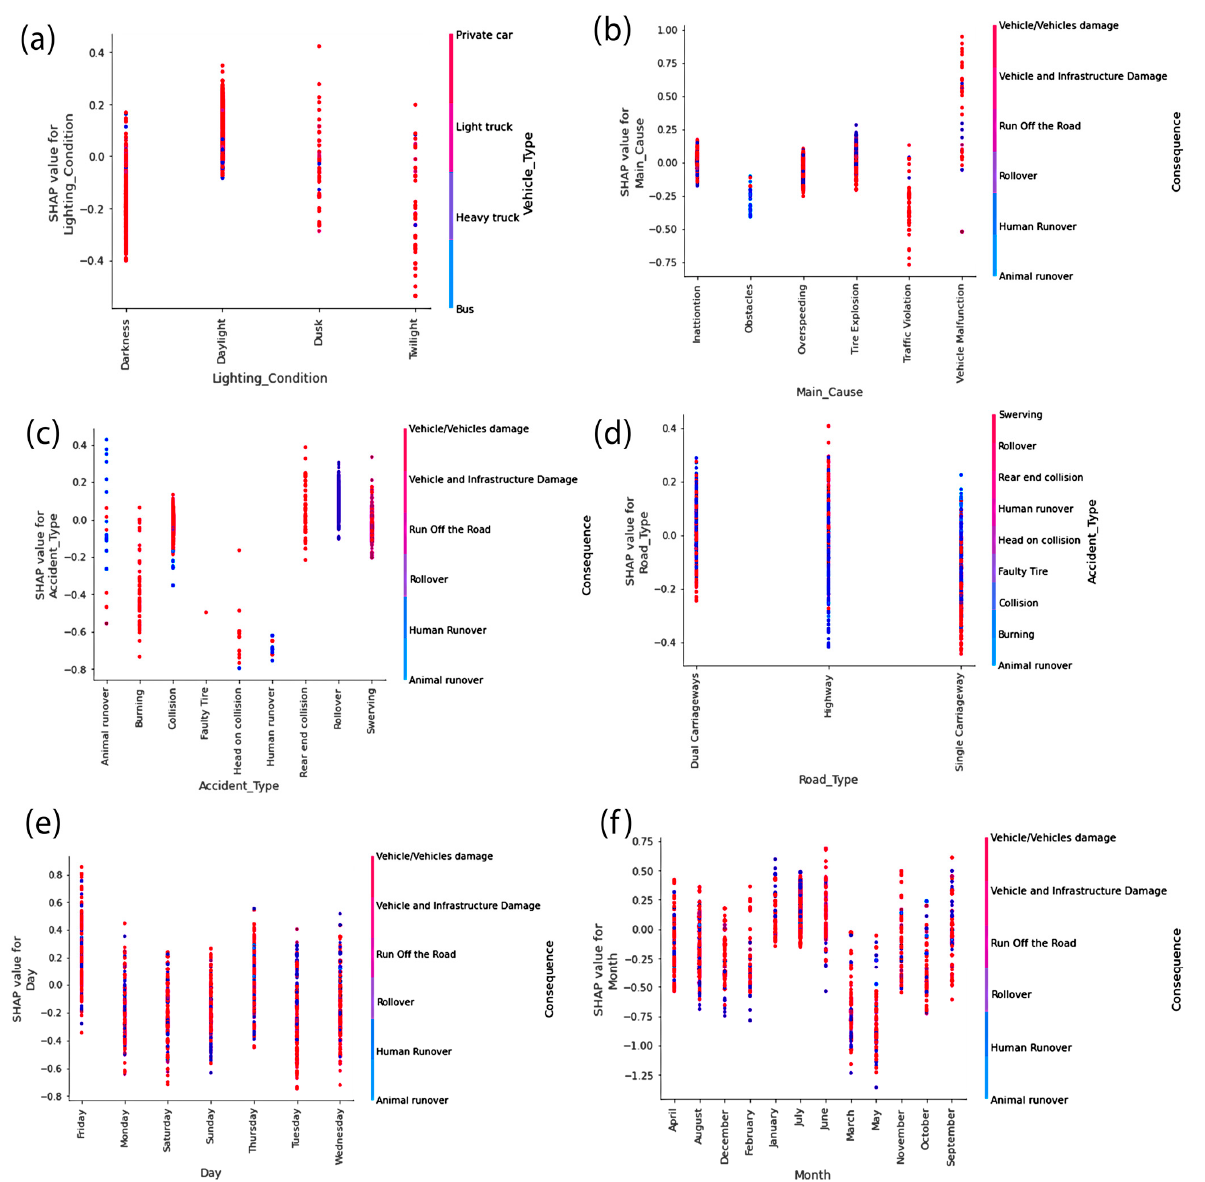
Figure 8. SHAP dependence plot for variable importance per class: ( a , b ) PDO class; ( c , d ) injury class; ( e , f ) death class.